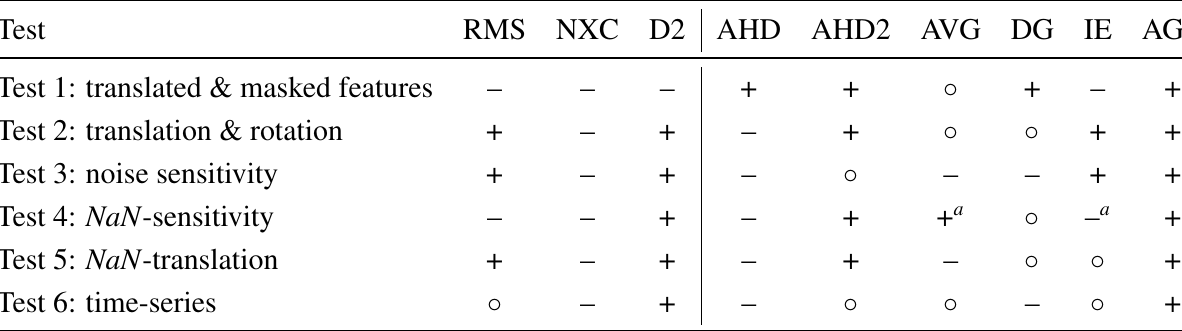
Table 2. Qualitative performance ratings of the image comparison measures for the 6 Tests in Section 4. The symbols indicate relative performance in the tests: + is good performance, ◦ is average performance and – is bad